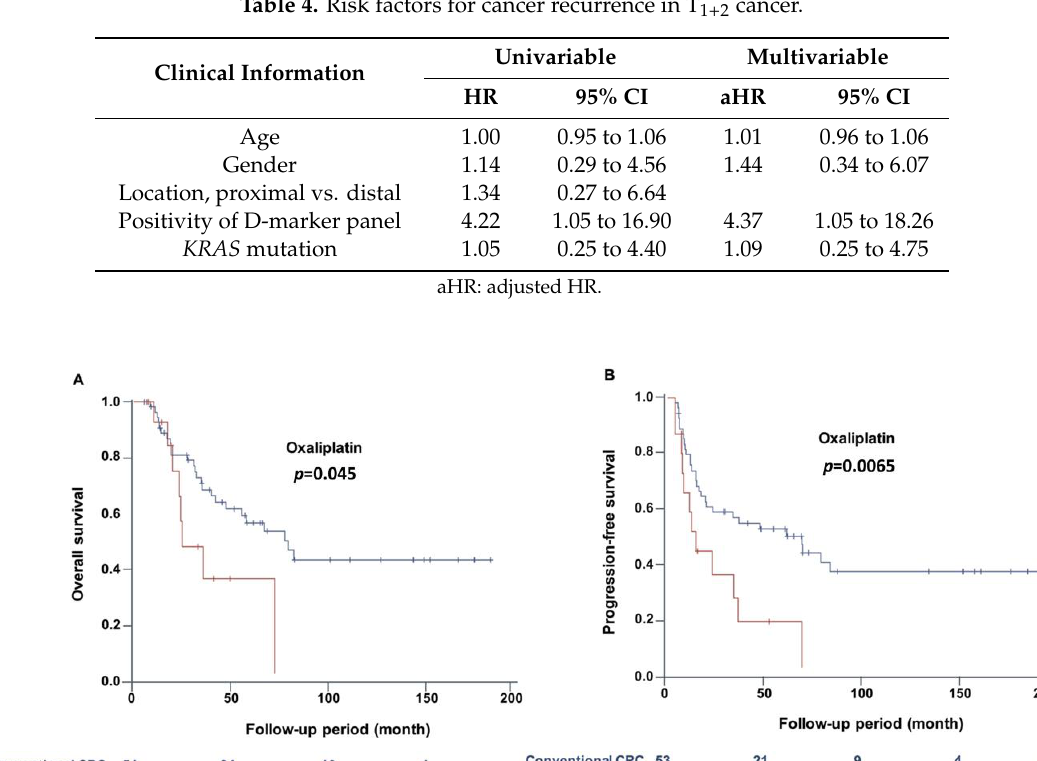
Table 4. Risk factors for cancer recurrence in T 1 + 2 cancer.